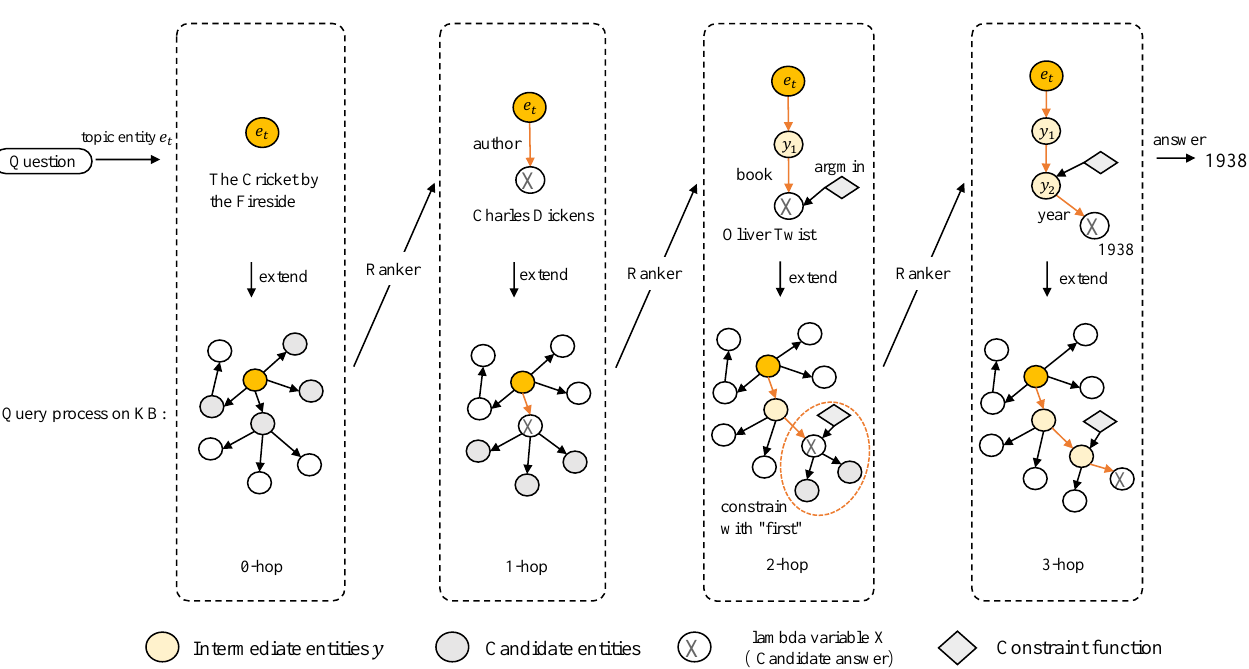
Figure 2. An example of the query process. Starting from a topic entity in the question, the extend and constrain operations are applied to generate the query graphs and eventually find the answer. The orange circles represent the constraint function to reduce the search space. Ranker is used to select the path with a higher score after ranking the candidate paths, such as the path made up of the orange arrow and the lambda variable X